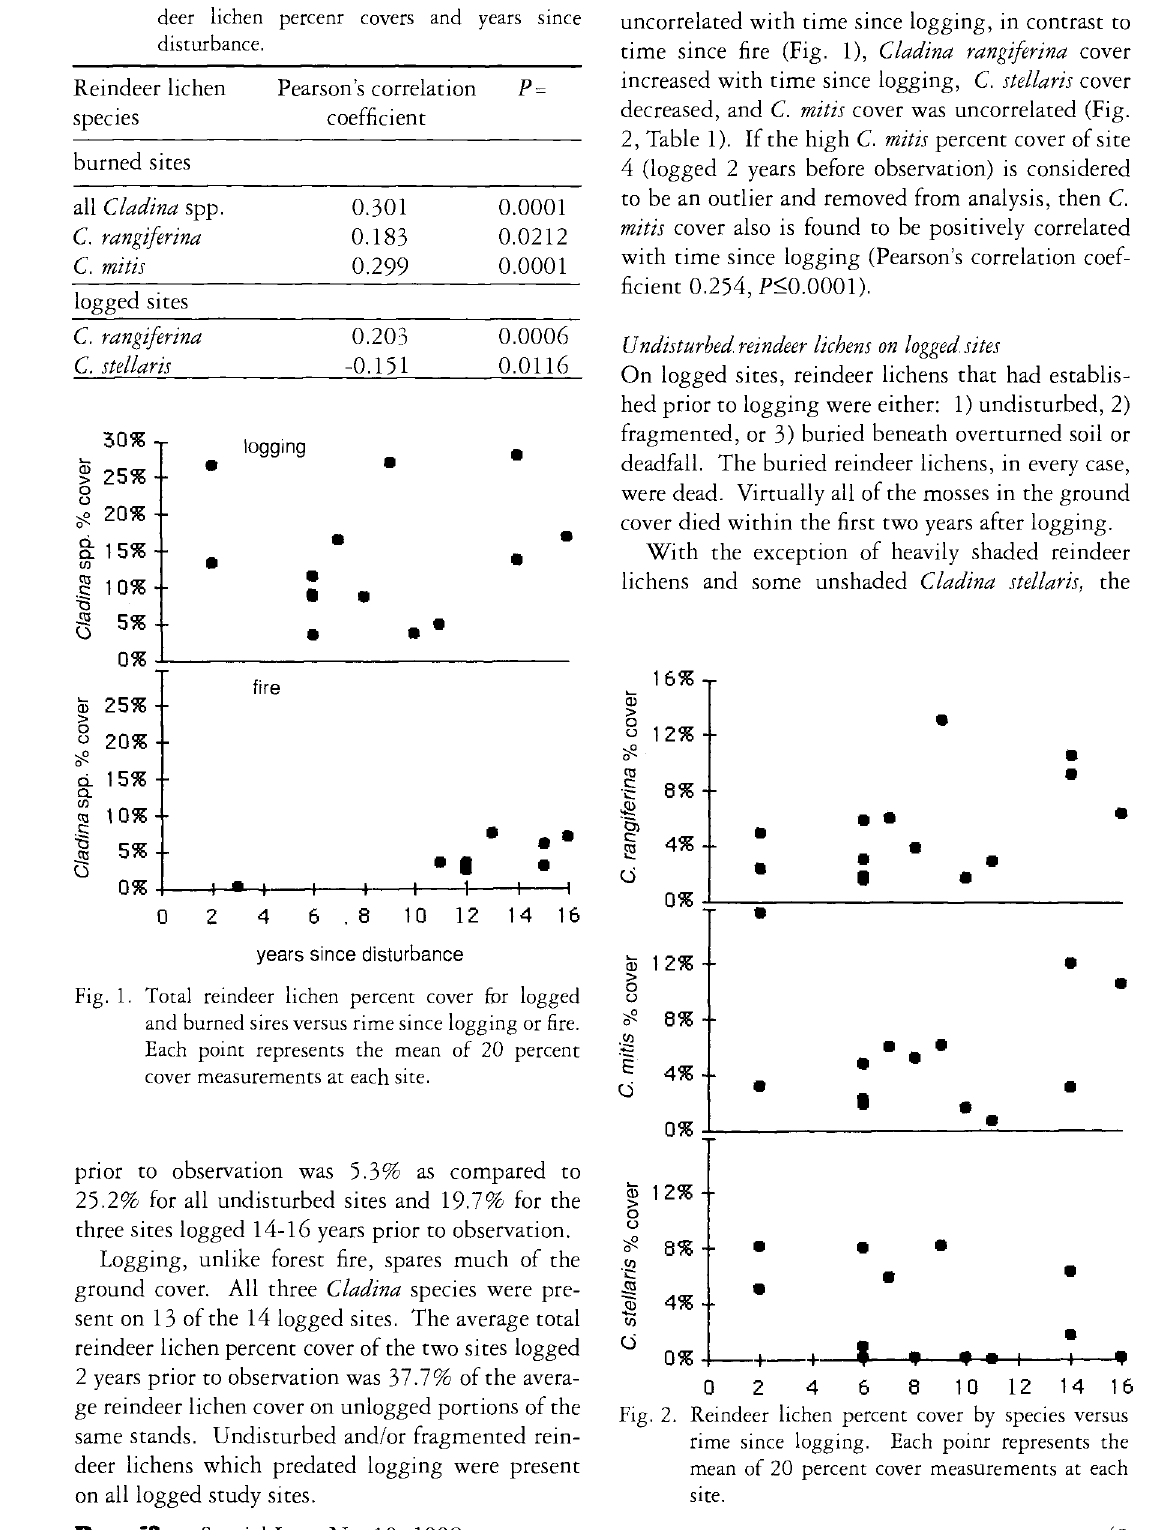
Fig. 2. Reindeer lichen percent cover by species versus rime since logging. Each poinr represents the mean of 20 percent cover measurements at each